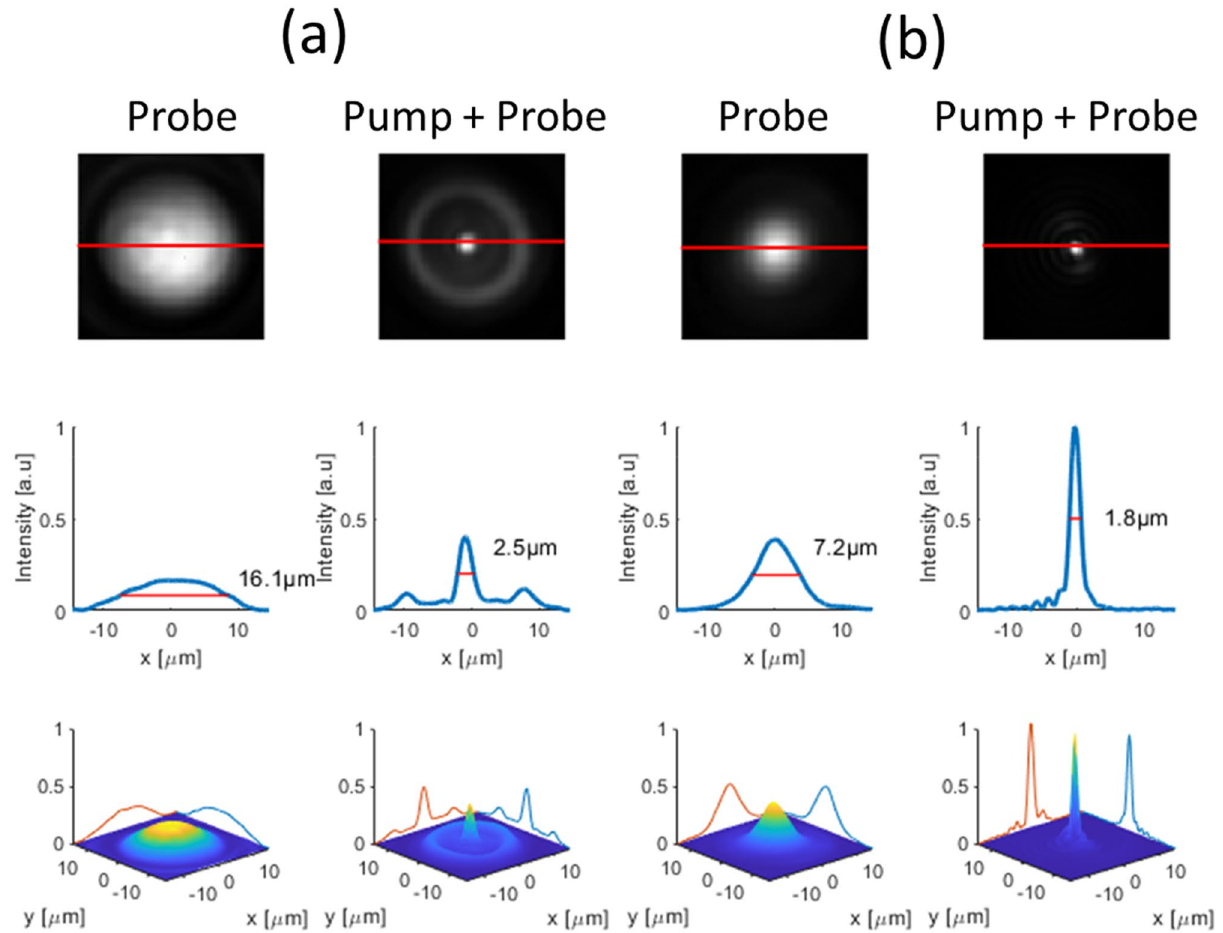
Figure 5. The effect of the relative diameter of pump-probe laser spots on the focusing. In the first row, we present the probe images generated in the sample with and without the effect of the pump, in two cases: ( a ) where the spot diameter of the probe is bigger than the pump’s spot diameter and ( b ) where the pump spot diameter is smaller than the probe beam’s diameter. On the second and third rows, we present the profile and the 3-D images, for each image,